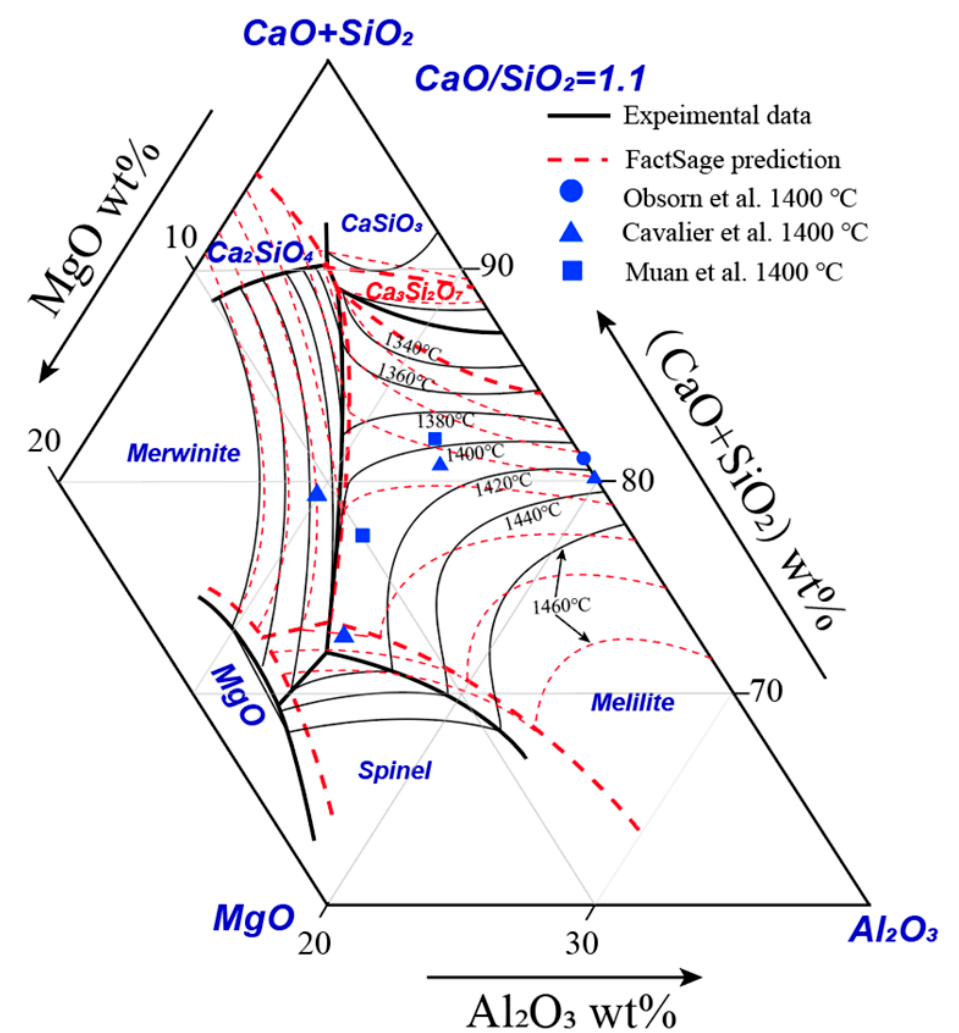
Figure 11. Experimentally determined pseudo-ternary phase diagram (CaO + SiO 2 )-Al 2 O 3 -MgO at a constant CaO/SiO 2 ratio of 1.1 [14] compare with the data reported by Osborn et al. [7], Cavalier et al. [10], Muan et al. [24] and FactSage prediction.